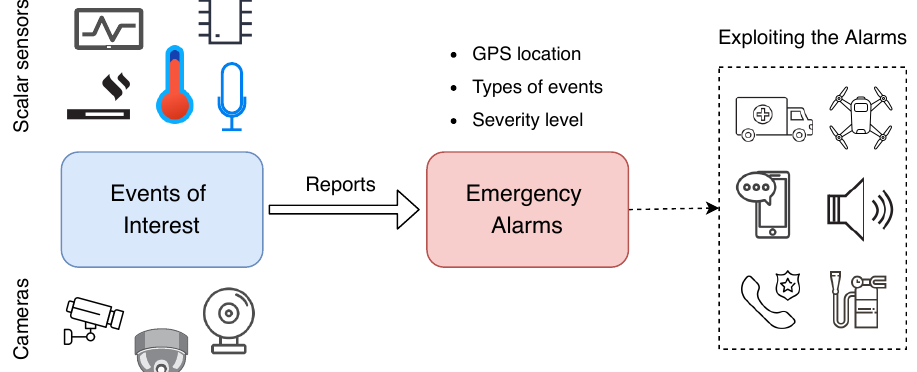
Figure 2. Emergency alerting based on the detection of events of interest by both scalar and camera